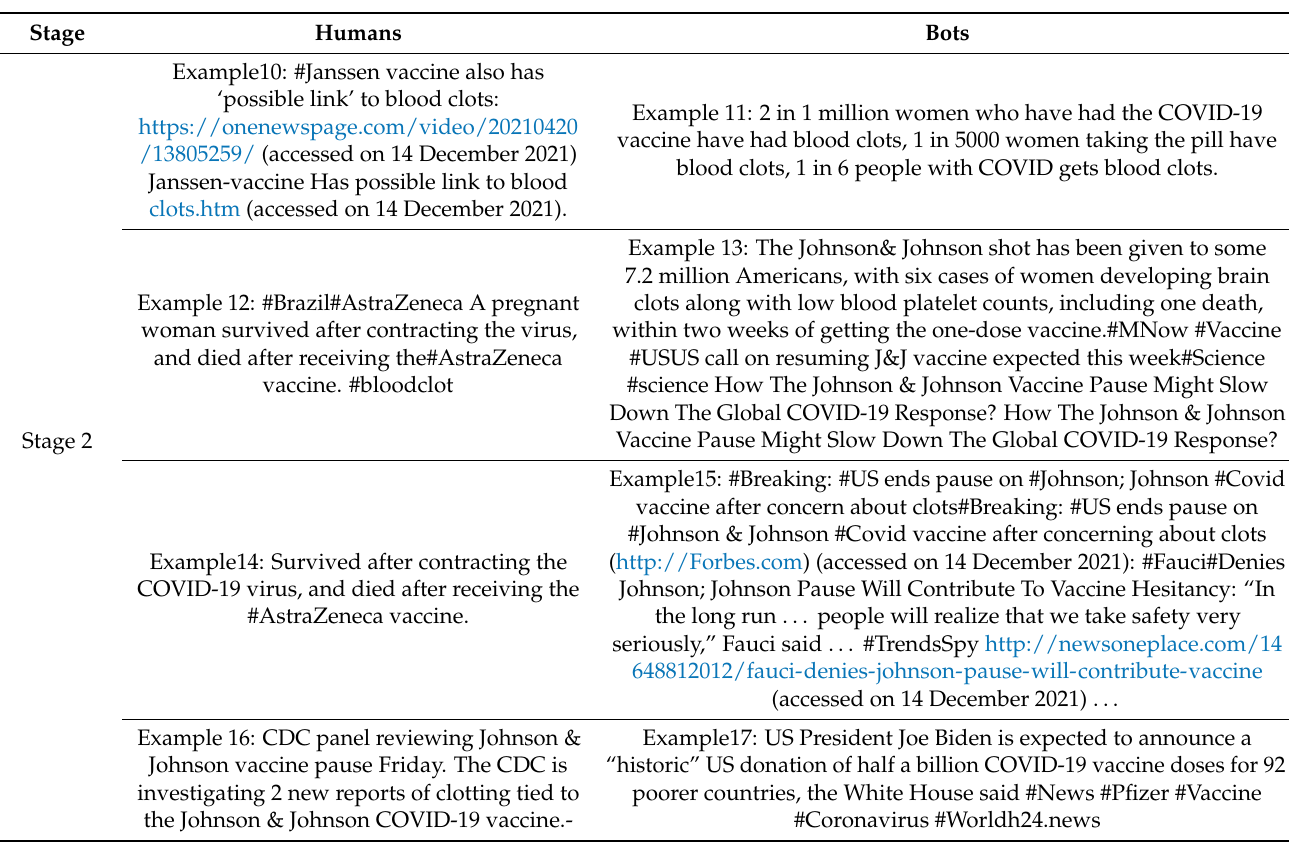
Table 4. Typical Tweets—Examples of Social Bots and Human Users at Stage